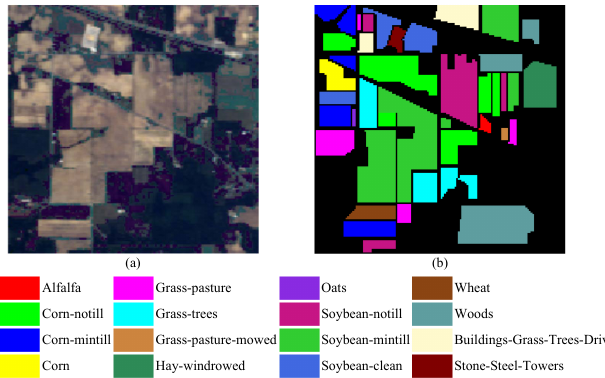
Figure 5. ( a ) False-color image and ( b ) ground truth for the IN data set.